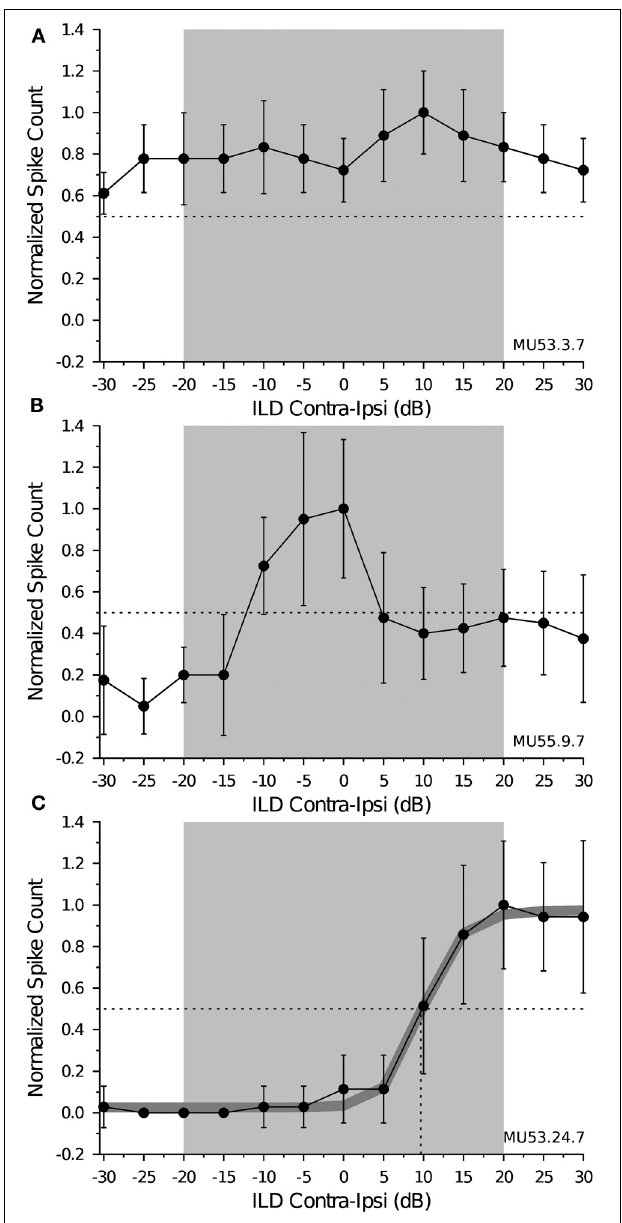
FIGURE 1 | Example interaural level difference (ILD) response functions measured from inferior colliculus (IC) neurons of Eptesicus fuscus . Each panel shows the mean ± SE spikes per stimulus, normalized to the response maximum and plotted as a function of binaural interaural level difference (ILD), measured in decibels (dB) as the sound pressure level (SPL) in the contralateral ear minus the SPL in the ipsilateral ear. The gray region spanning ± 20dB represents a conservative estimate of the range of dominant ILD cues for an adult Eptesicus fuscus and the horizontal dotted line represents 50% of the maximum spike count. During data collection, the SPL presented to the contralateral ear was kept constant while the SPL presented to the ipsilateral ear was varied in 5dB steps from − 30dB to + 30dB re contralateral ear. The abscissa is the binaural ILD measured as the SPL of the contralateral stimulus minus the SPL of the ipsilateral stimulus, with negative values indicating the ipsilateral sig- nal was louder than the contralateral signal and positive values indicating the